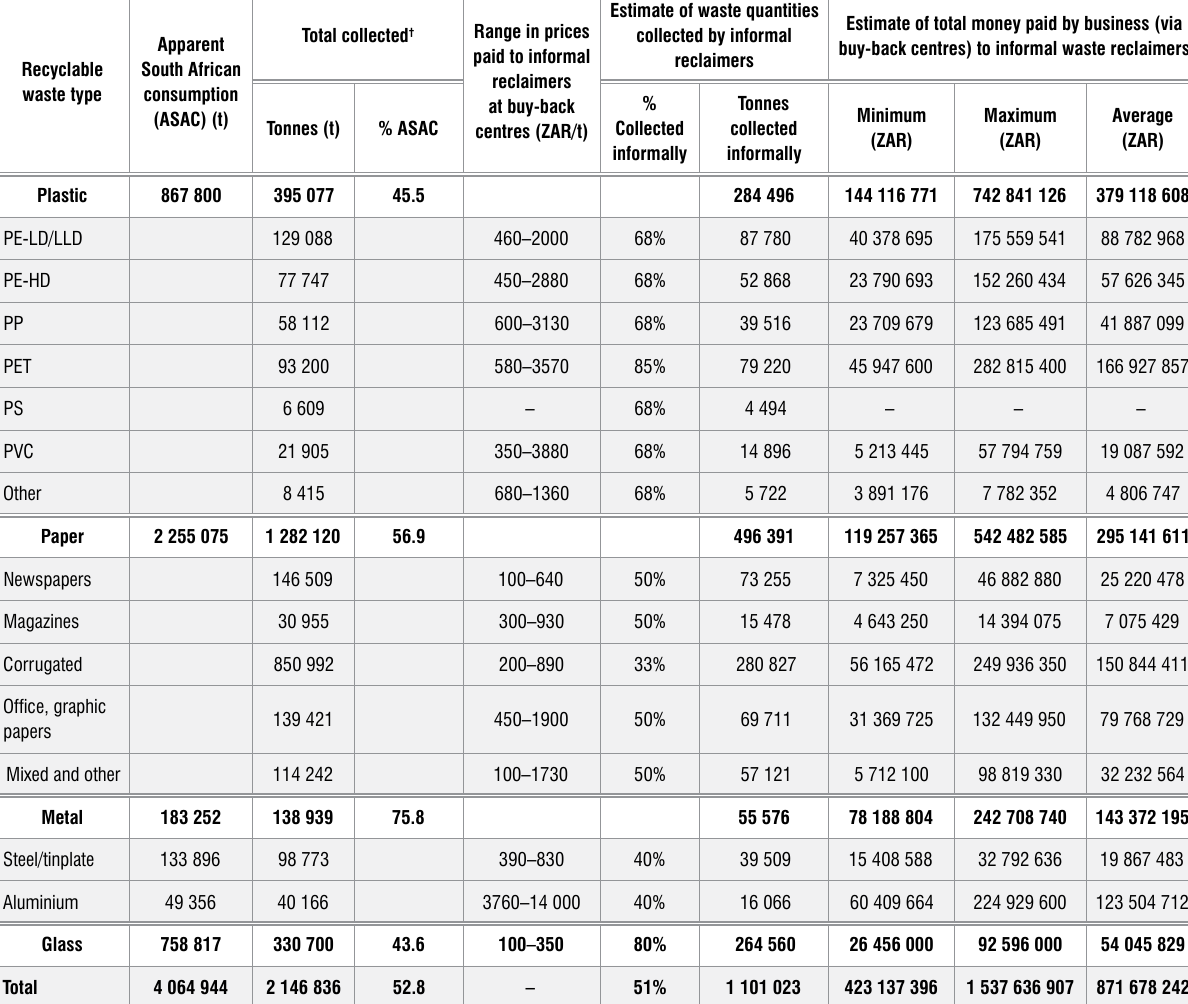
Estimate of waste quantities Range in prices collected by paid to informal